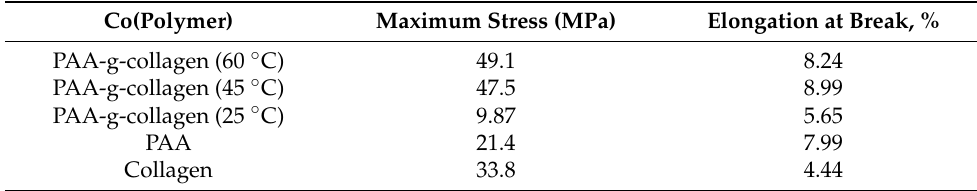
Table 4. Tensile mechanical properties of films based on PAA, and collagen copolymers synthesized at 25, 45, or 60 °C, and of pure PAA and collagen samples.